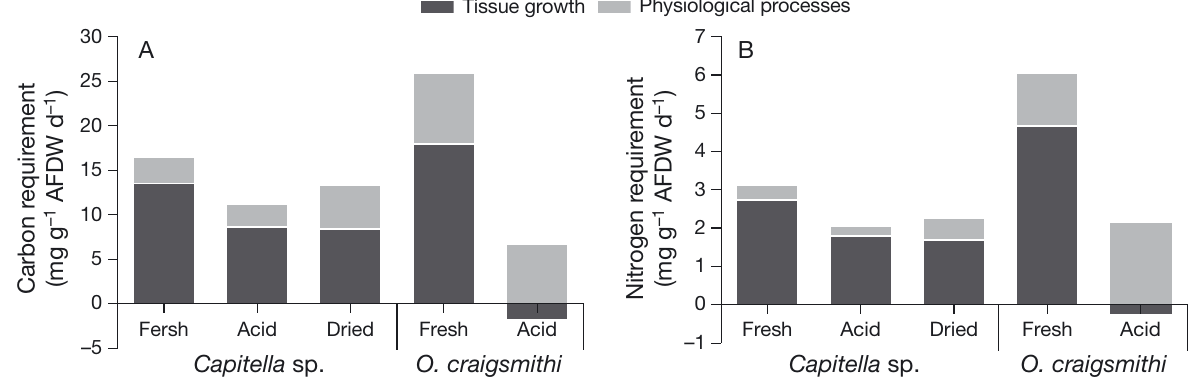
Fig. 2. (A) C and (B) N requirement estimated for Capitella sp. and Ophryotrocha craigsmithi fed fresh or preserved (acid- ified or oven-dried) salmon faeces. For nutrients incorporated into tissue growth, growth and tissue content data from Nederlof et al. (2019) were used (see also our Section 2.2.3 for calculation methods). Nutrients required for physiological processes were based on respiration (C) and excretion (N) measurements from the present study (see Section 2.2.2